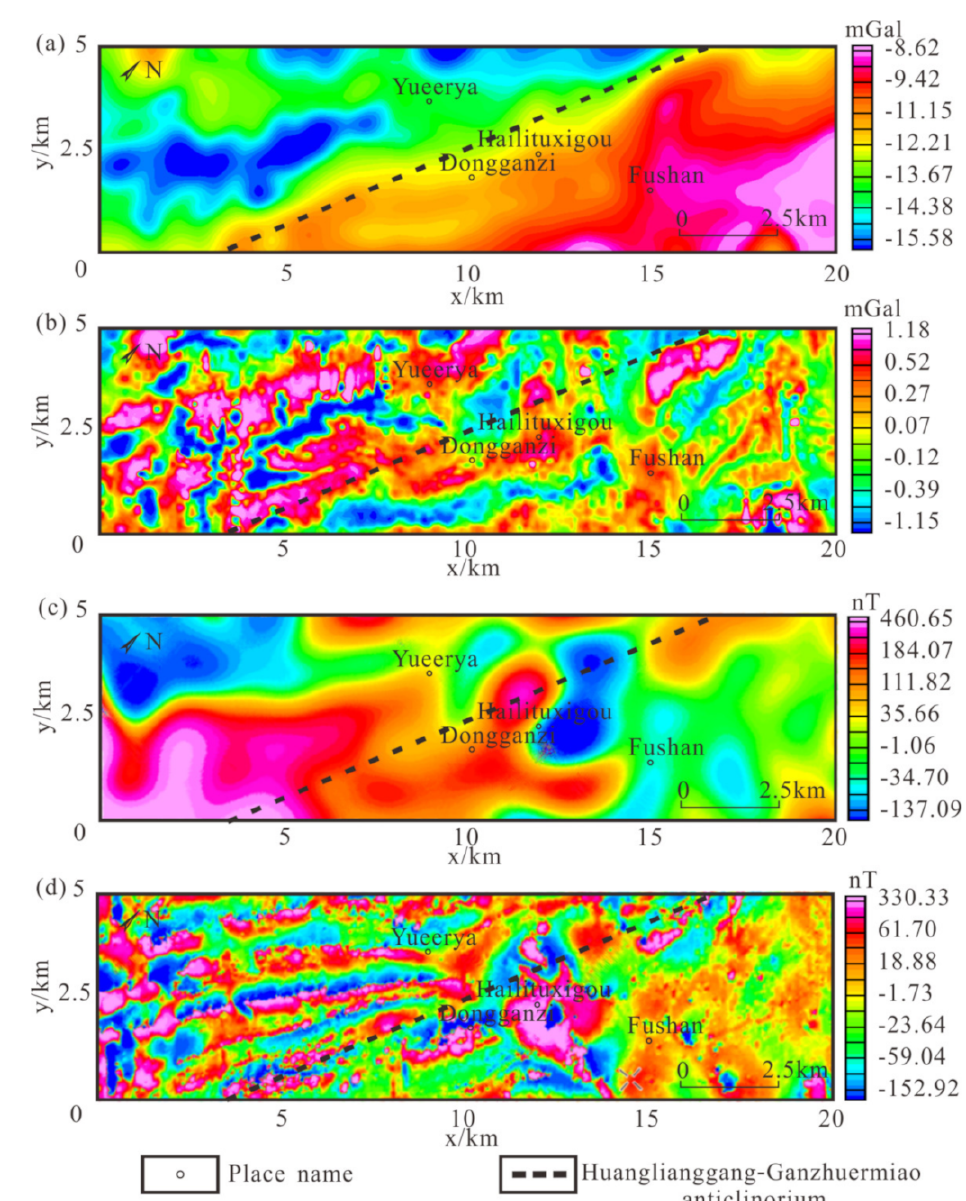
Figure 8. Field separation results of Bouguer gravity anomaly and RTP magnetic anomaly: ( a ) Re- gional gravity anomaly; ( b ) Residual gravity anomaly; ( c ) Regional magnetic anomaly; ( d ) Residual magnetic